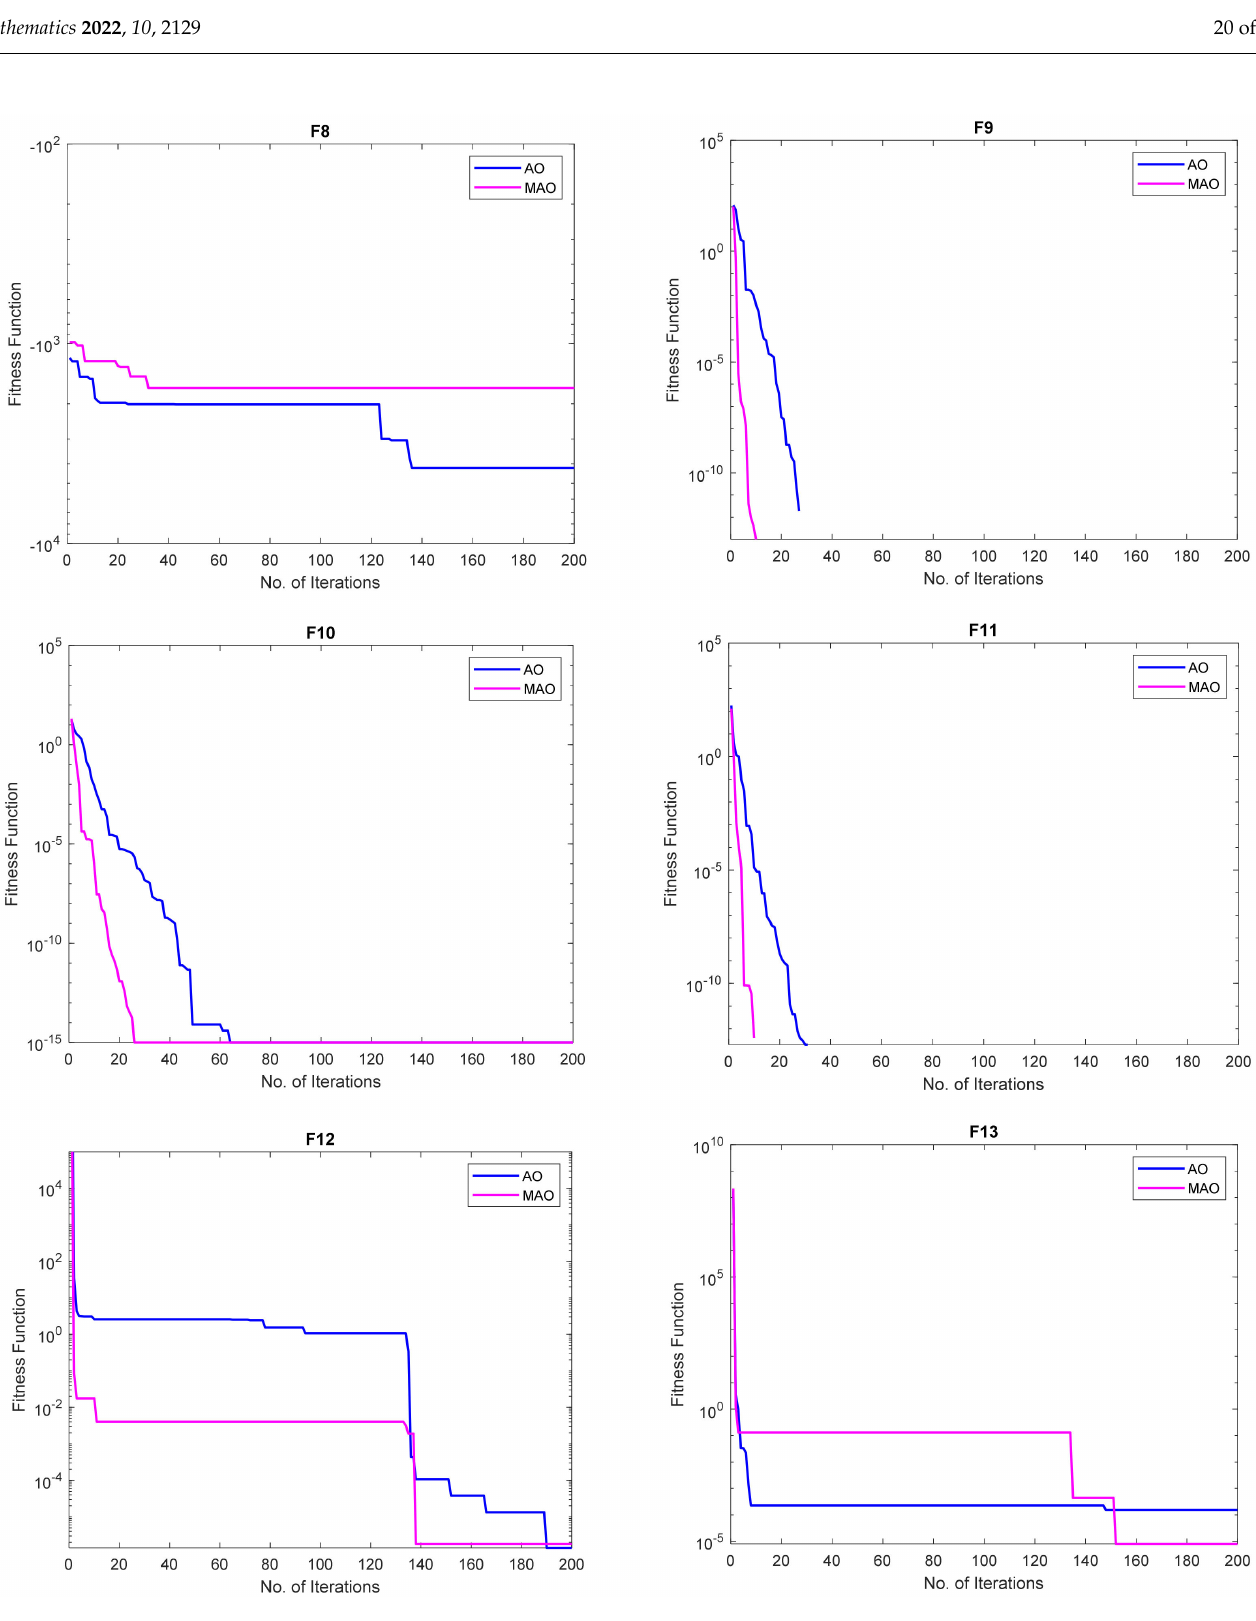
Figure 4. Convergence analysis of multimodal benchmark functions with D =